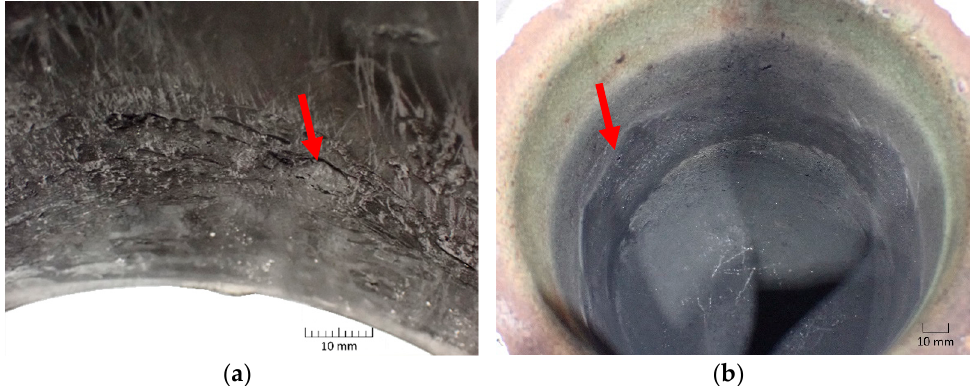
Figure 14. Visual appearance of the crucibles after the experiments: ( a ) traces of attack on the Al 2 O 3 crucible wall in Design 1; ( b ) appearance of the MgO crucible after experiment 2 with obvi- ous